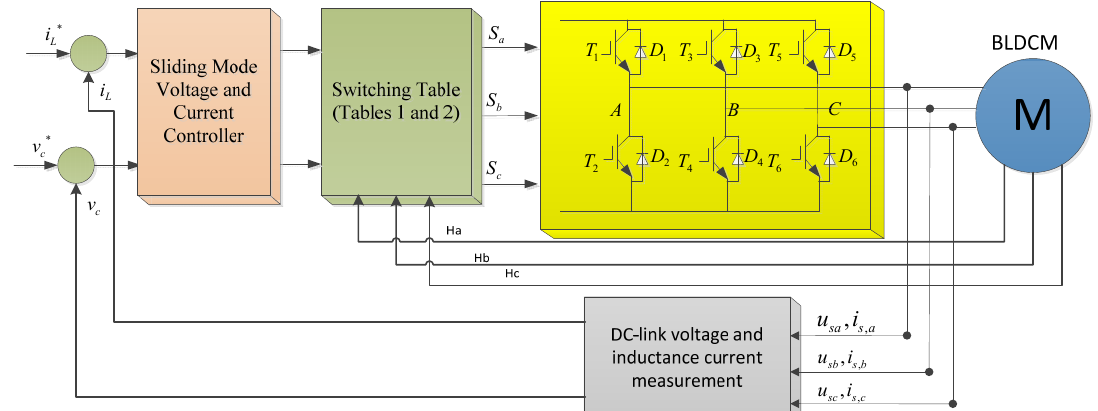
Figure 5. Control block diagram of the system using sliding mode controller